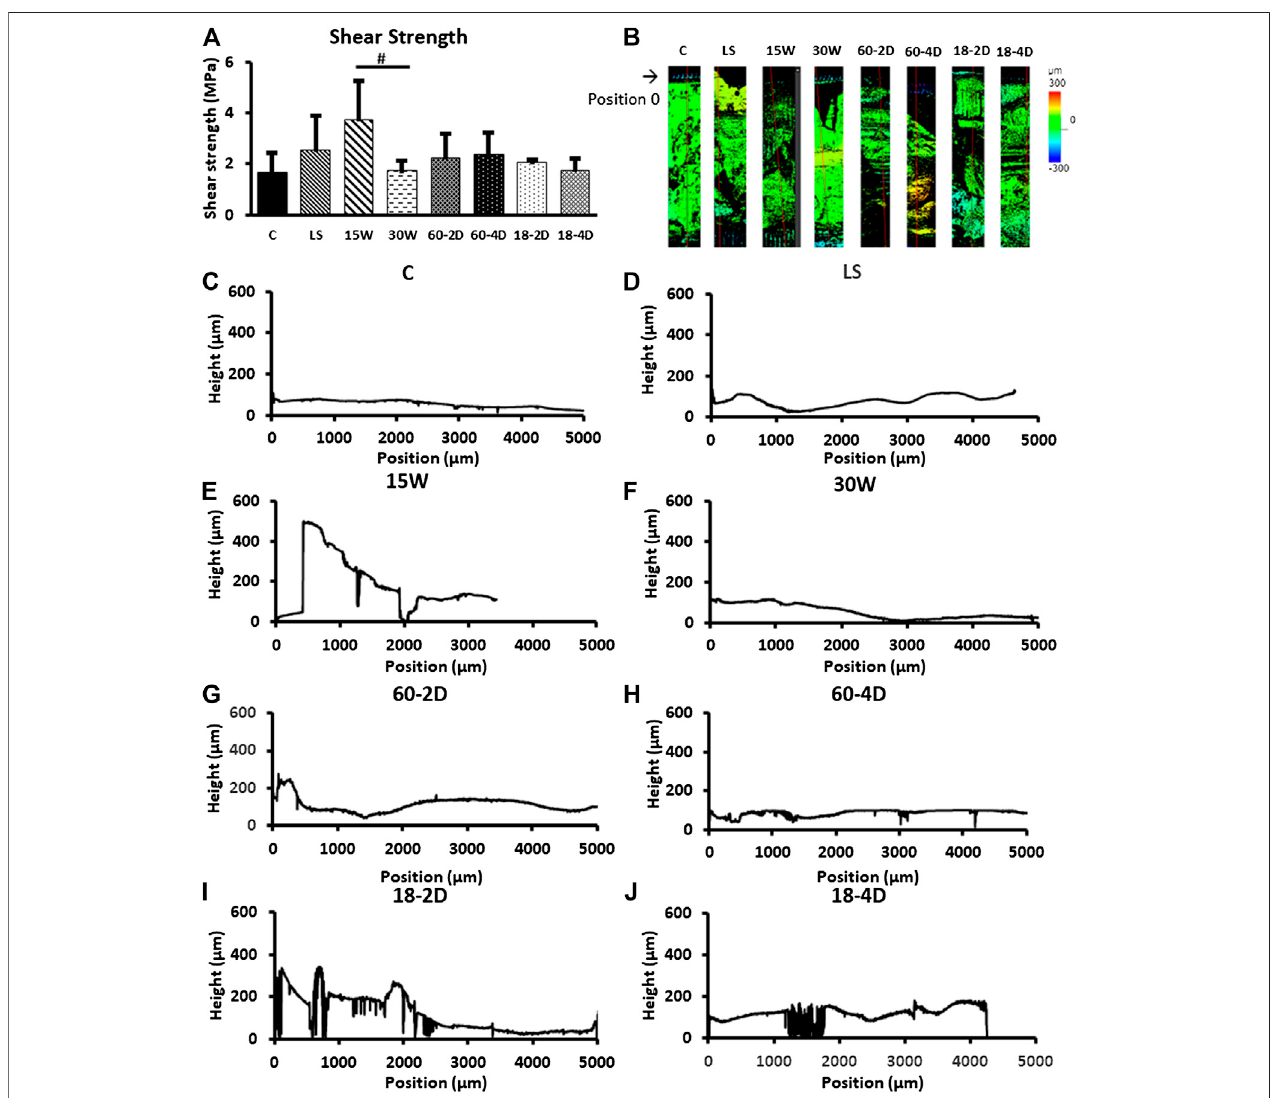
FIGURE7| Interfacialenergy. (A) Theadhesivestrengthofgroups.15Whad p (cid:2) 0.0571withrespecttothecontrolgroup,and p (cid:2) 0.0495withrespecttothe30W. (B) Height map of the samples after adhesive shear test. (C) – (J) Height pro fi le of the samples. *Indicates p ＜ 0.05 with respect to control group. # Indicates p ＜ 0.05 between the groups being compared. n (cid:2) 3 for all